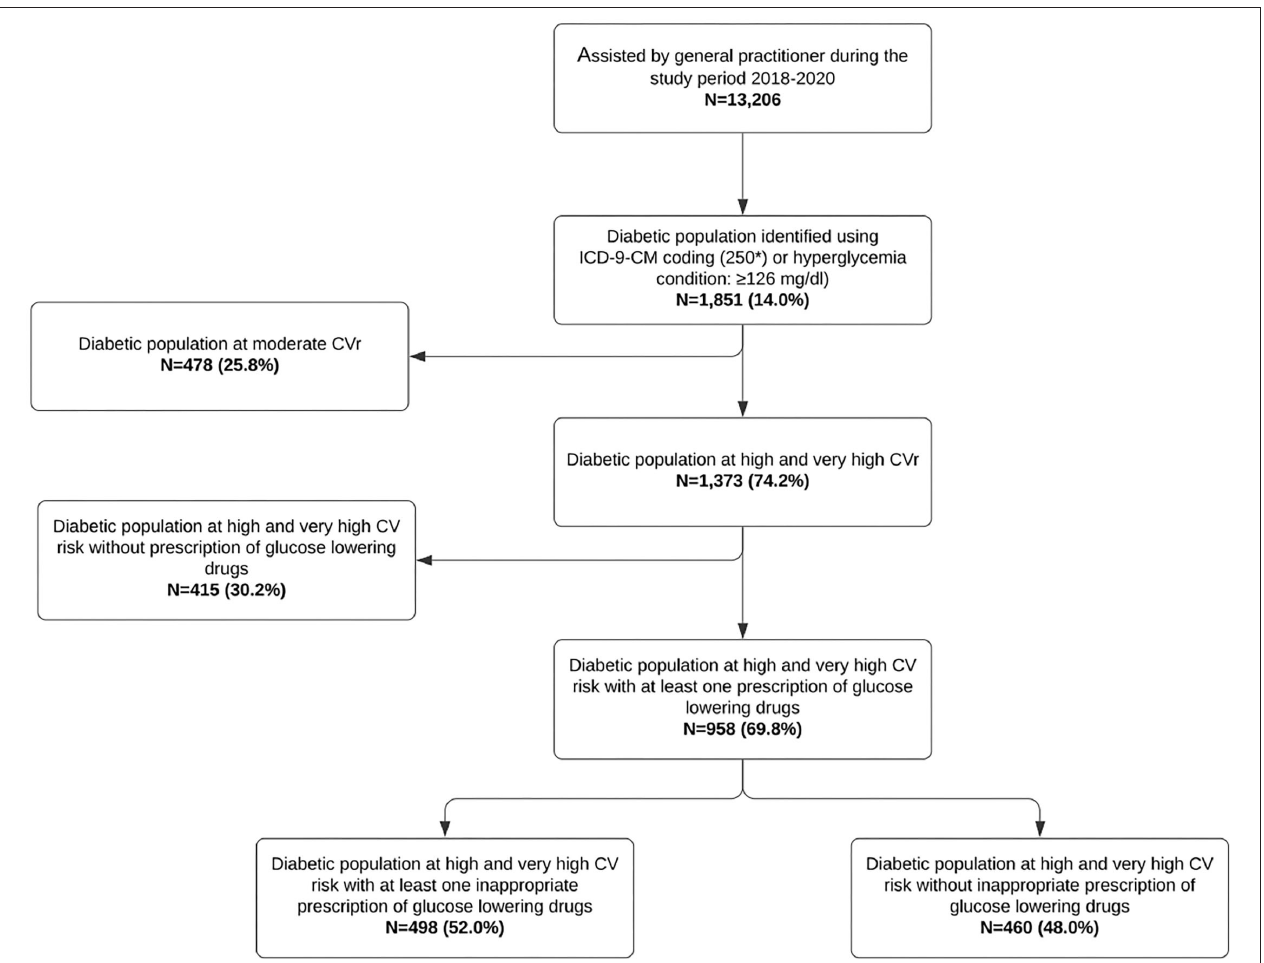
FIGURE 2 | Identification of the study population: focus on diabetic